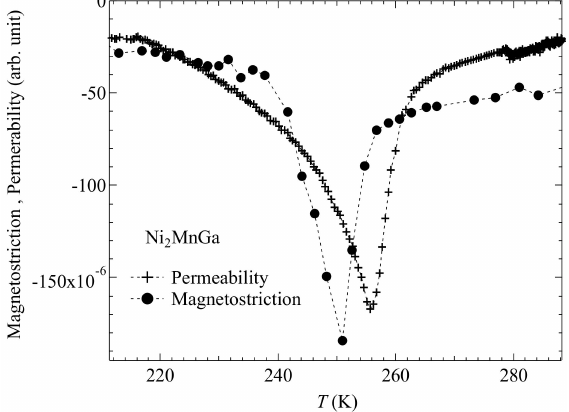
Figure 8. Temperature dependence of permeability at zero magnetic fields and magnetostriction of Ni 2 MnGa at 1.6 T. Dotted lines are guides to eyes. The plots were obtained from Ref. [27]. T. Sakon et al. Metals 2017 , 7 , 410. MDPI, doi:10.3390 /